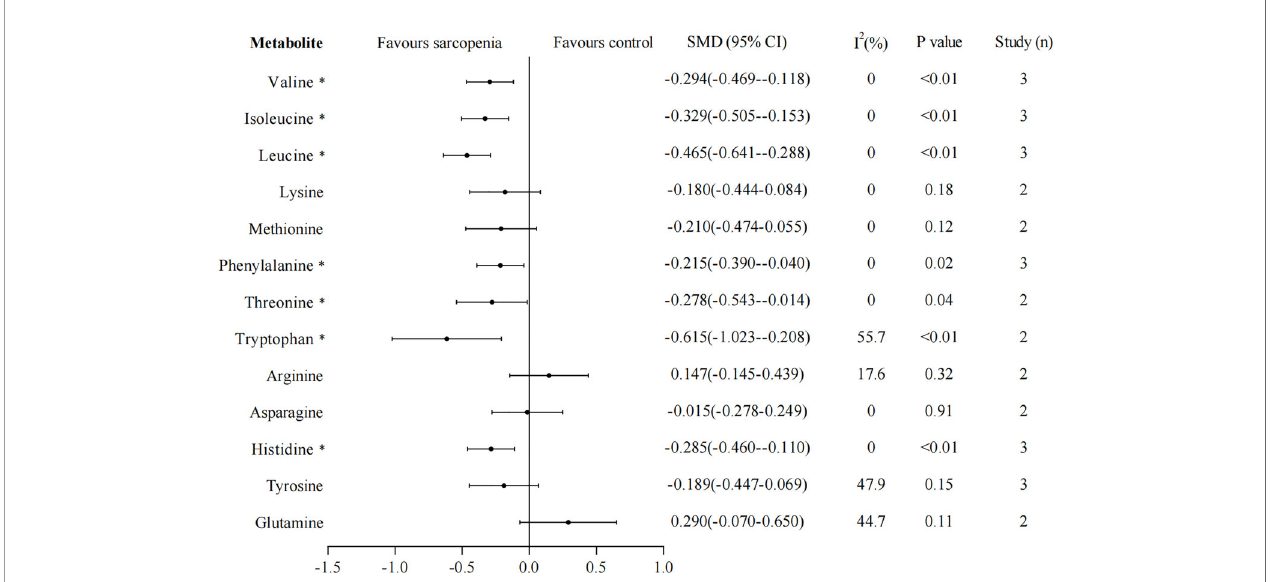
FIGURE 3 | Sensitivity analyses for amino acid metabolomics in sarcopenic individuals vs . non-sarcopenic individuals (restricting to studies using bioelectrical impedance analysis to measure muscle mass). Overall estimate obtained from forest plots of the random-effects meta-analysis using the SMD. Closed circles and horizontal bars represent the overall estimate and 95% CI. SMD, standardized mean difference. CI, con fi dence interval. Asterisks (*) indicate P-value